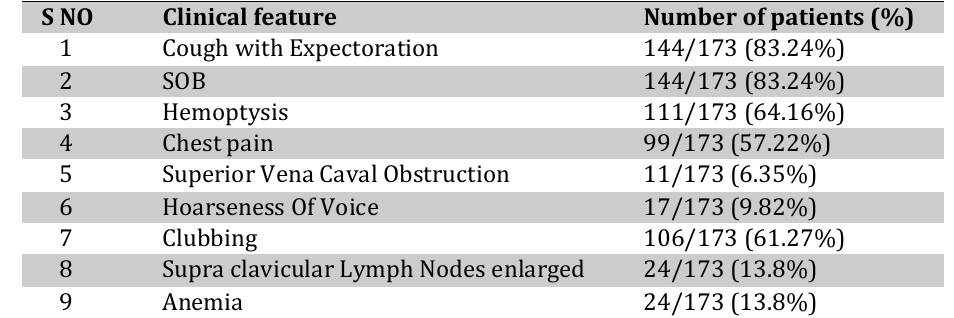
Table 2 . Clinical features .